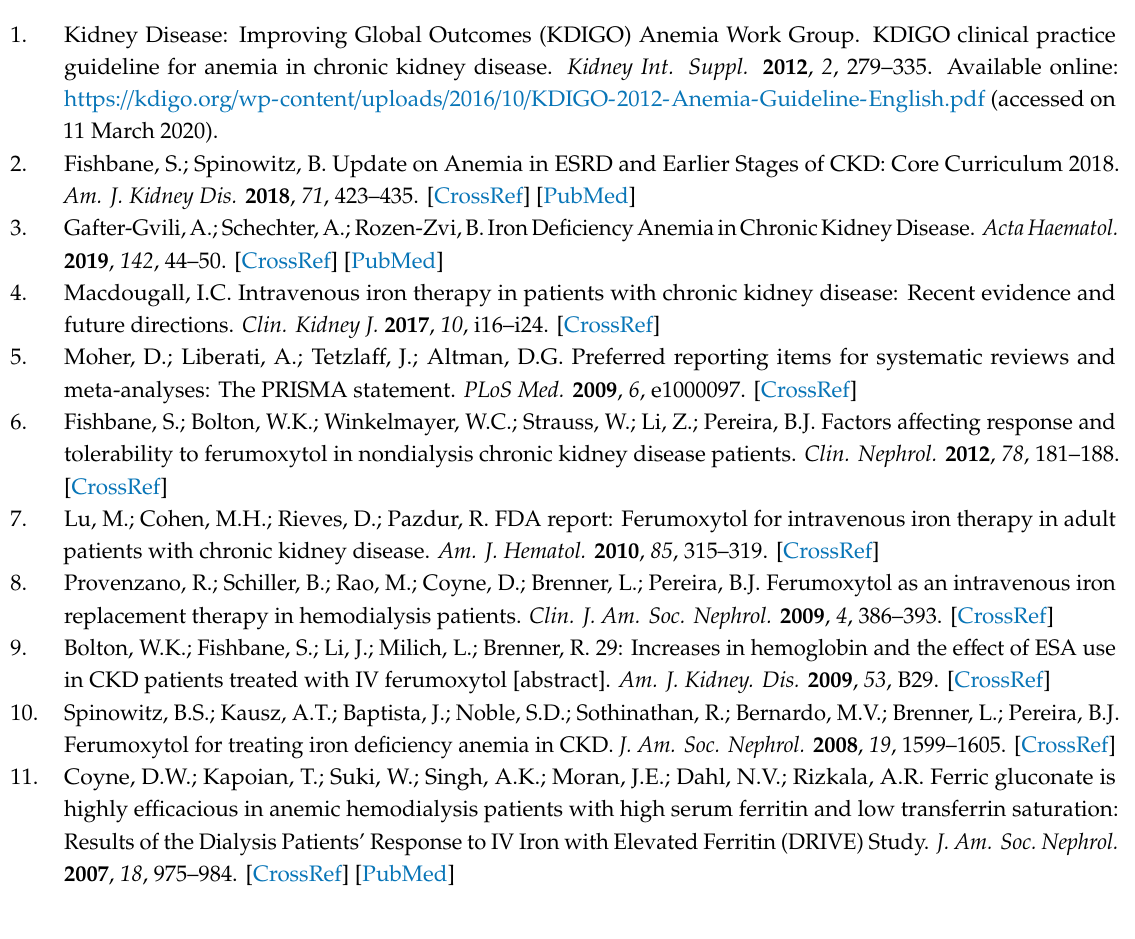
Table S1: Participants, interventions, comparators, and outcomes in (a) the trials that provided numerical data for the meta-analysis and (b) the trials that did not provide numerical data for the meta-analysis, Table S2: Risk of bias in the eligible studies, Figure S1: Inconsistency plot on random e ff ects for the SUCRA assessable iron supplements values in the subgroups of (a) patients in the KDIGO GFR categories 3A to 5, and (b) dialysis patients, Panel S1: Search strategy formulae and search